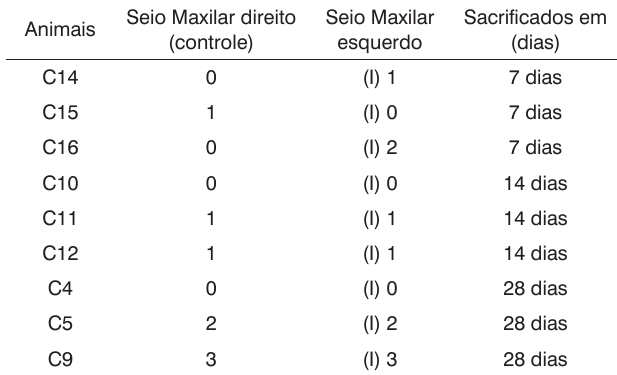
Tabela 2. Avaliação histológica da inflamação presente na mucosa dos animais do Grupo 2.